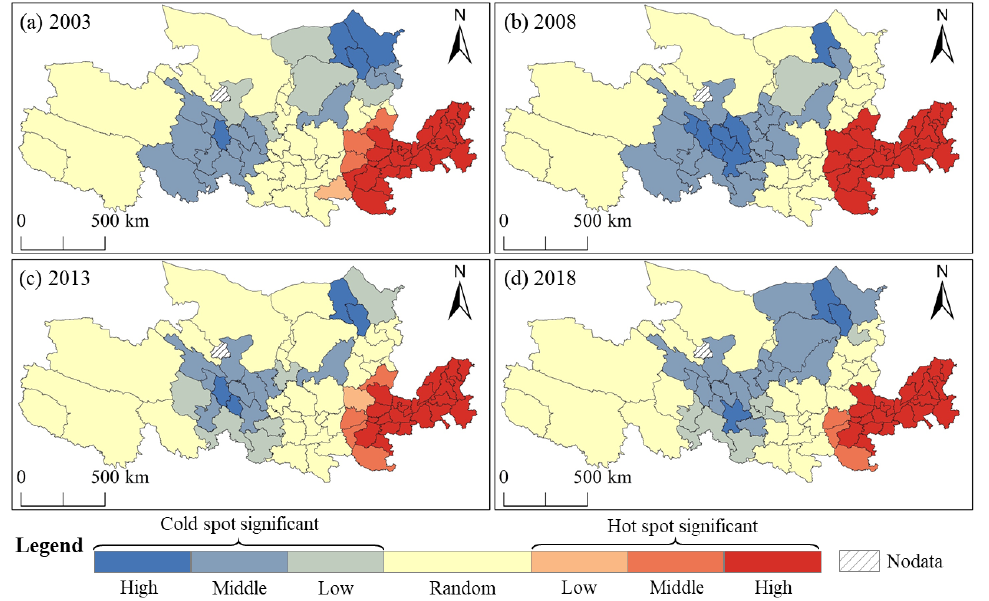
Figure 6. Spatial agglomeration of the CCD between RLUT and FS in the YRB. a, b, c and d denote the spatial agglomeration of the CCD between RLUT and FS in 2003, 2008, 2013 and 2018, respectively.